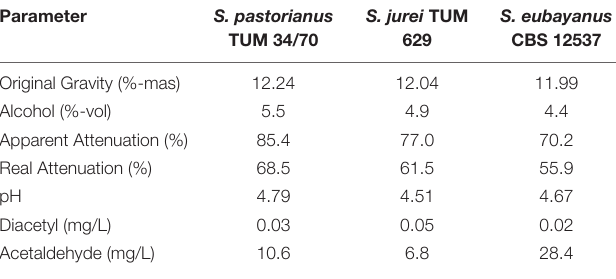
TABLE 2 | Analysis of finished beers fermented by S. pastorianus (TUM 34/70), S. jurei (TUM 629) and S. eubayanus (CBS 12537) at a fermentation temperature of 15 ◦